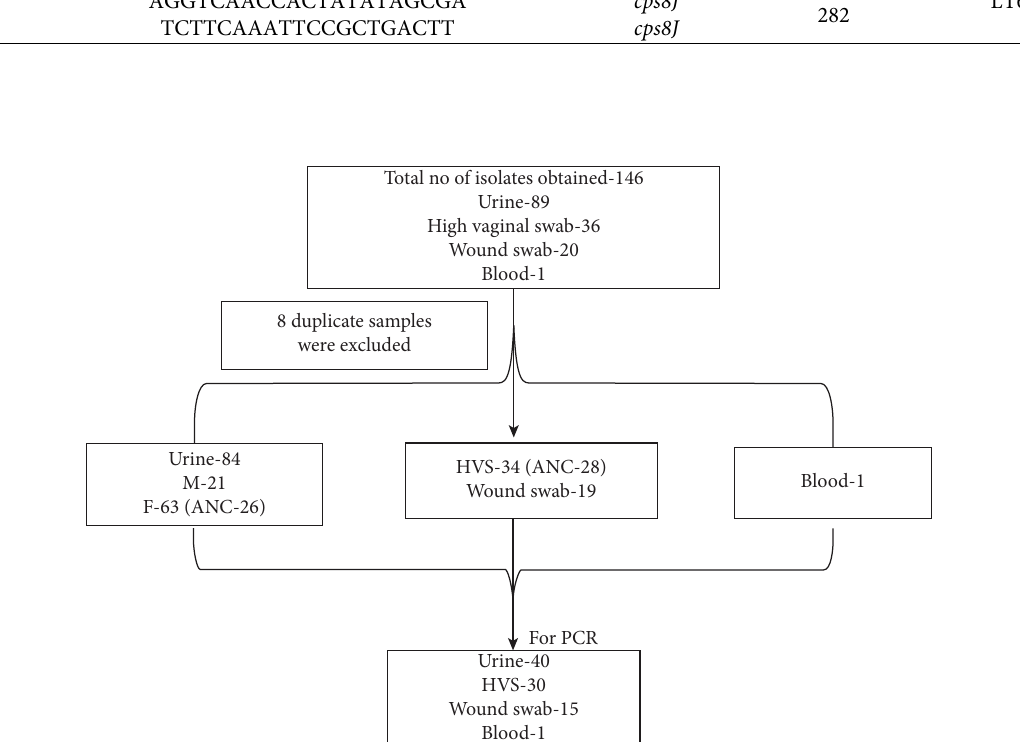
Figure 1: Characteristics of the study population. Table 2: Genotype distribution of the S.agalactiae strain according to clinical specimens.